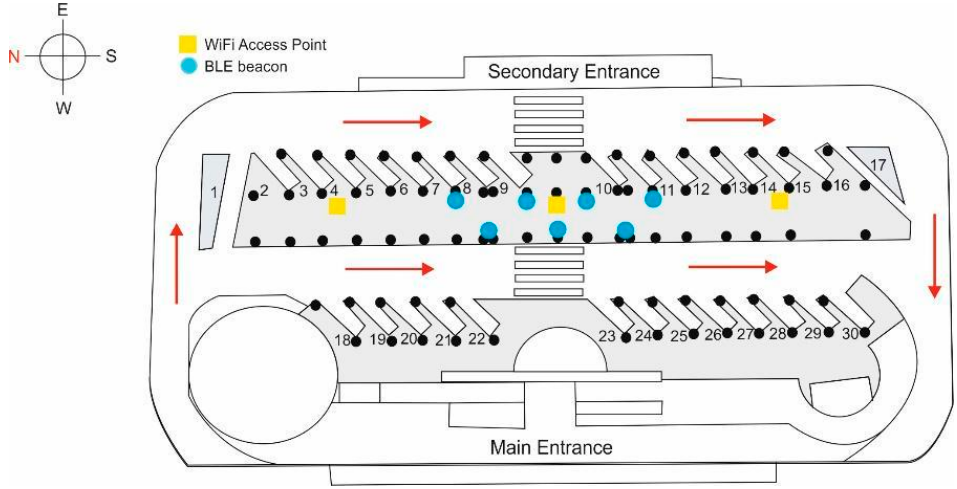
Figure 2. Schematic view of key elements of the bus station and Wi-Fi APs and BLE